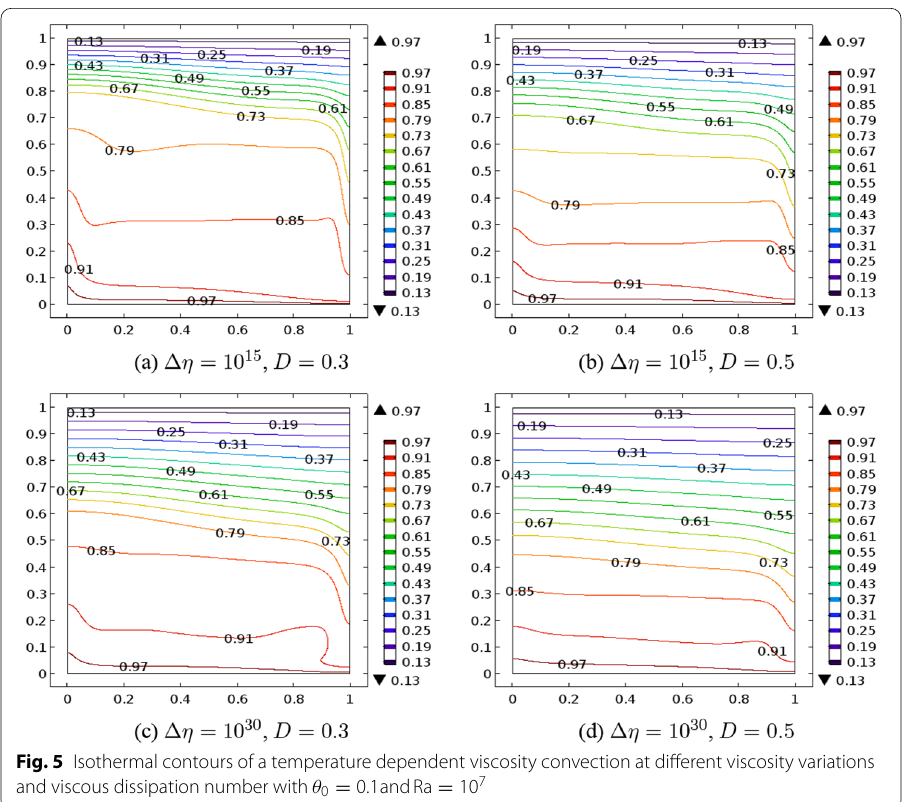
Fig. 5 Isothermal contours of a temperature dependent viscosity convection at different viscosity variations and viscous dissipation number with θ 0 = 0.1 and Ra = 10 7